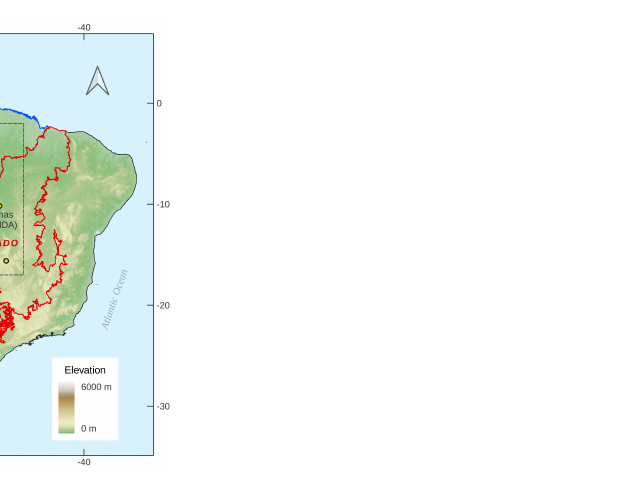
Figure 2. The spatial domain considered for model BRASIL-SR in the present study. The yellow circles show the location of the observational data acquisition sites. The domain is indicated with a dashed line rectangle. Limits for the Amazonia and Cerrado biomes are in blue and red,